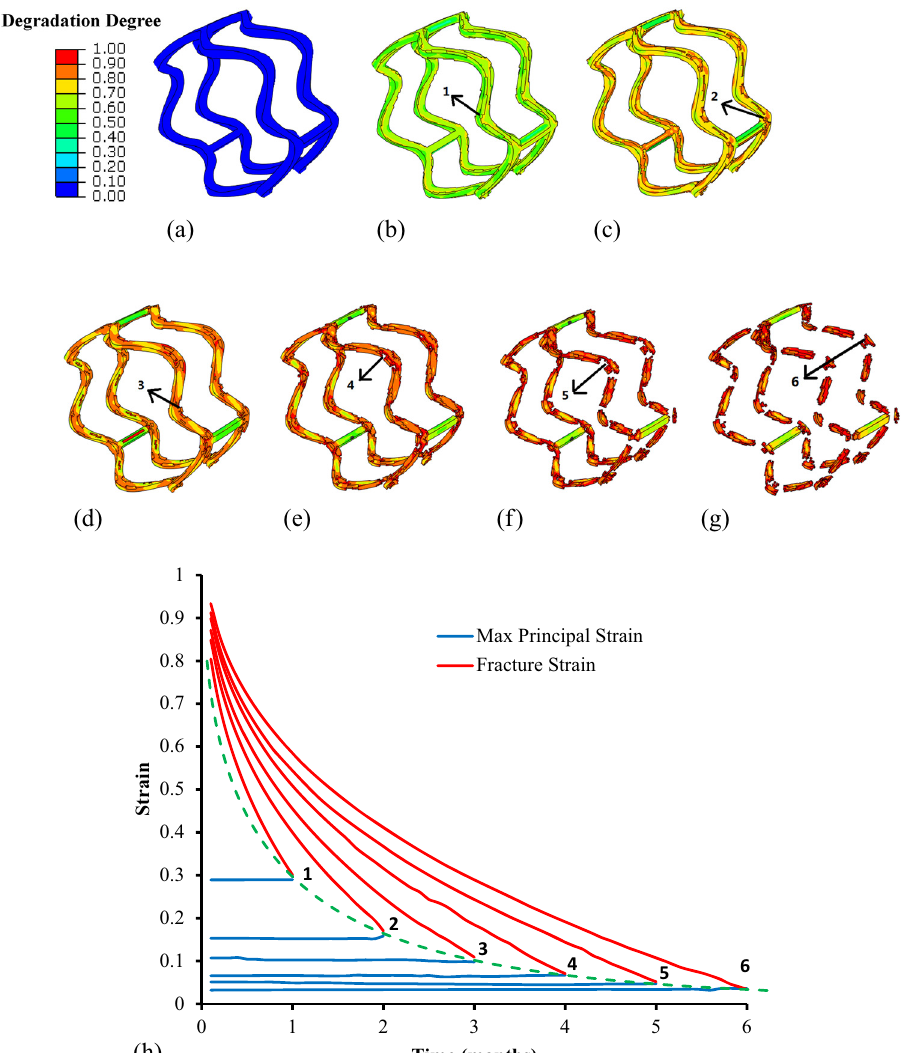
Figure 4: Contour of degradation degree at ( a ) 0 month, ( b ) fi rst month, ( c ) second month, ( d ) third month, ( e ) fourth month, ( f ) fi fth month, and ( g ) sixth month. ( h ) Maximum principal strain versus fracture strain at six representative